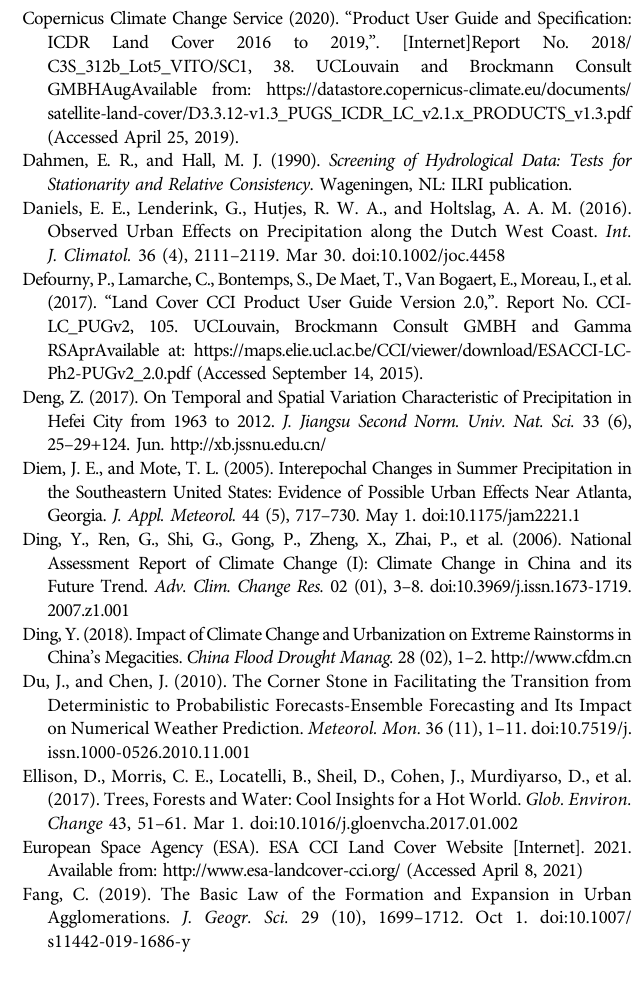
background in Figure 1 courtesy of Stamen Design.